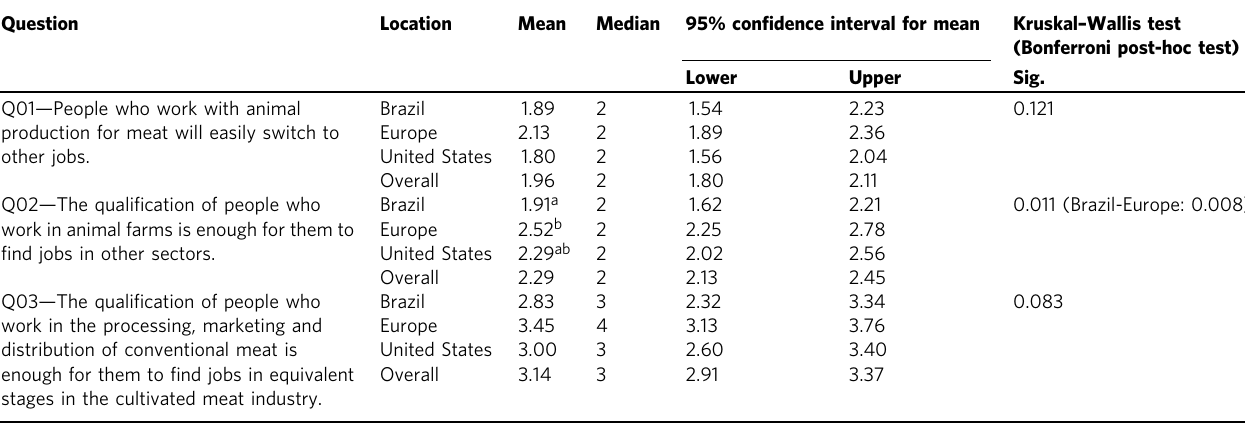
Table 3 Responses to questions regarding the impact of cultivated and plant-based meat production on jobs in the current conventional meat industry in Brazil ( N = 35), Europe ( N = 56), and the United States ( N = 45) using Likert scale from 1 (strongly disagree) to 5 (strongly agree), from August to October,